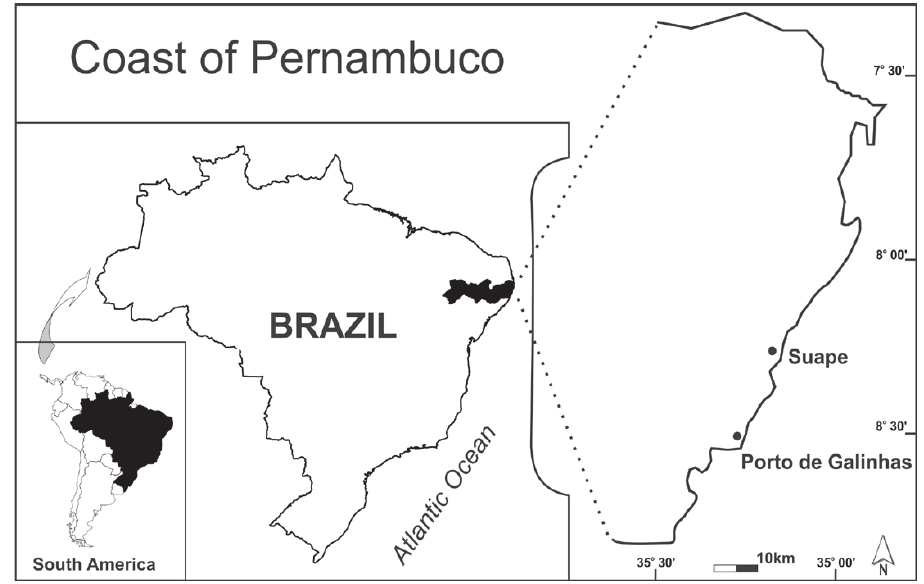
Figure 1 - Location of the Suape and Porto de Galinhas beaches along the coast of the State of Pernambuco, in northeastern